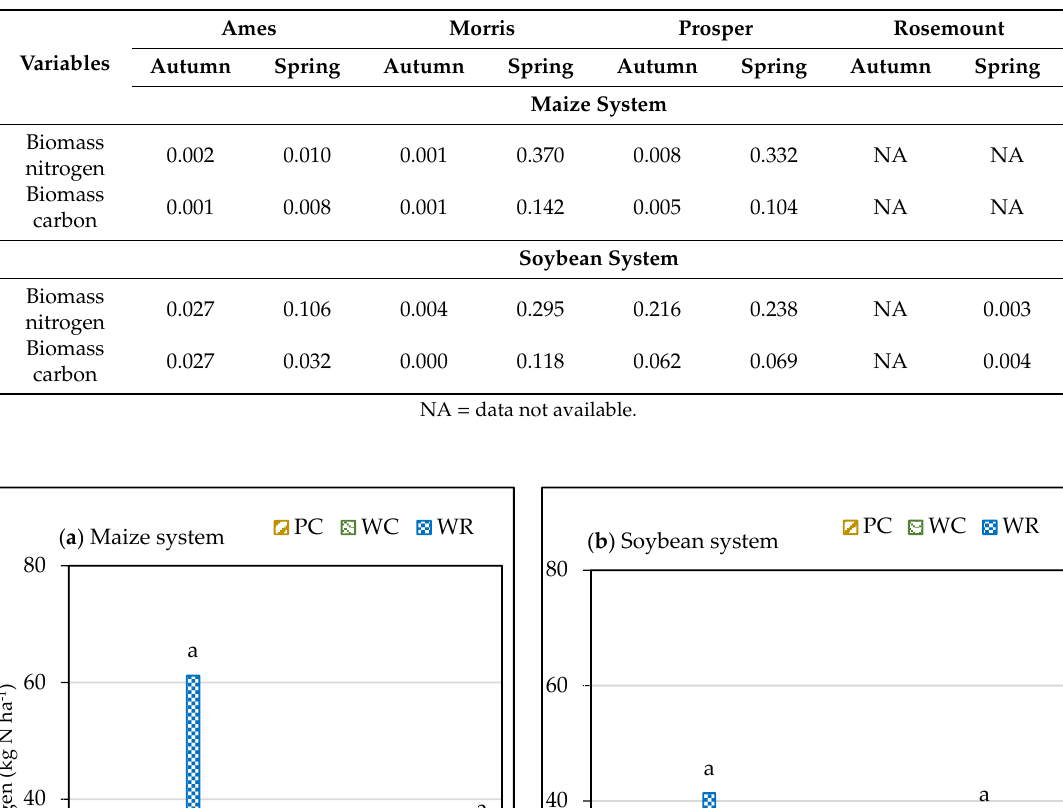
Table 3. Analysis of variance table showing level of significance ( p -values) of cover crop biomass nitrogen and carbon accumulation in autumn and spring at Ames, Morris, Prosper, and Rosemount when cover crops were interseeded in standing maize and soybean.